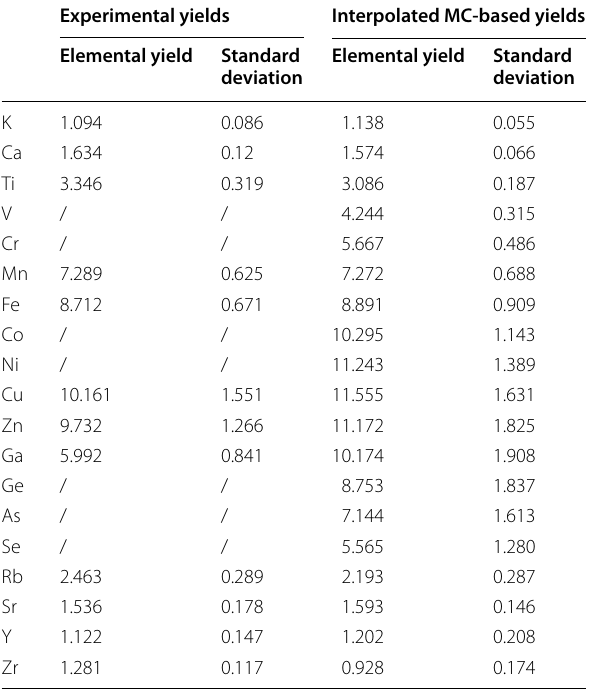
Fig. 6 a Confocal detection limit (DL) based on ATHO‑G ( K α lines only) for a live time of 1000 s. Interpolation based on a weighted linear least squares quadratic fit, error bars are 3σ following standard error propagation. b Experimental yields ( Y i,exp ) based on ATHO‑G ( K α lines only).